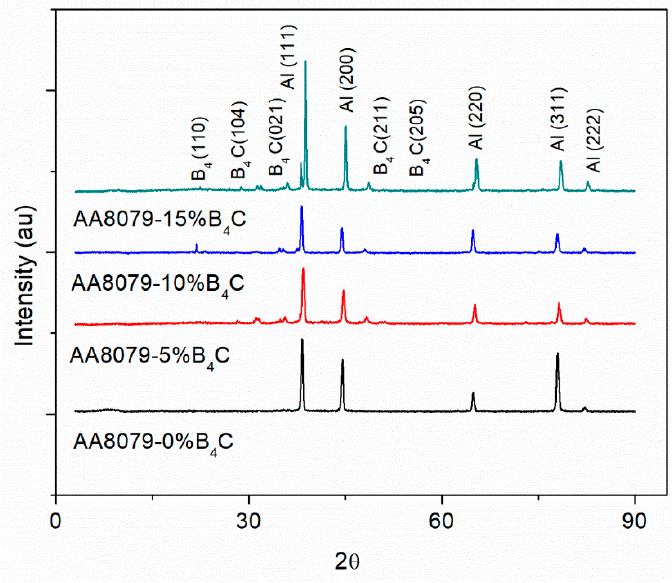
Figure 6 . XRD patterns of AA8079-B 4 C composites. Figure 6. XRD patterns of AA8079-B 4 C composites.